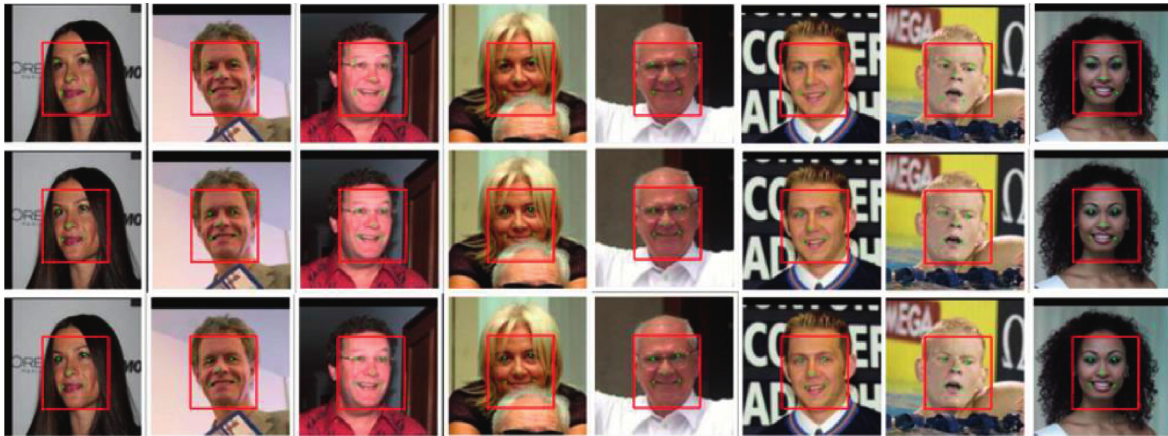
Figure 8: Effect picture of facial landmark